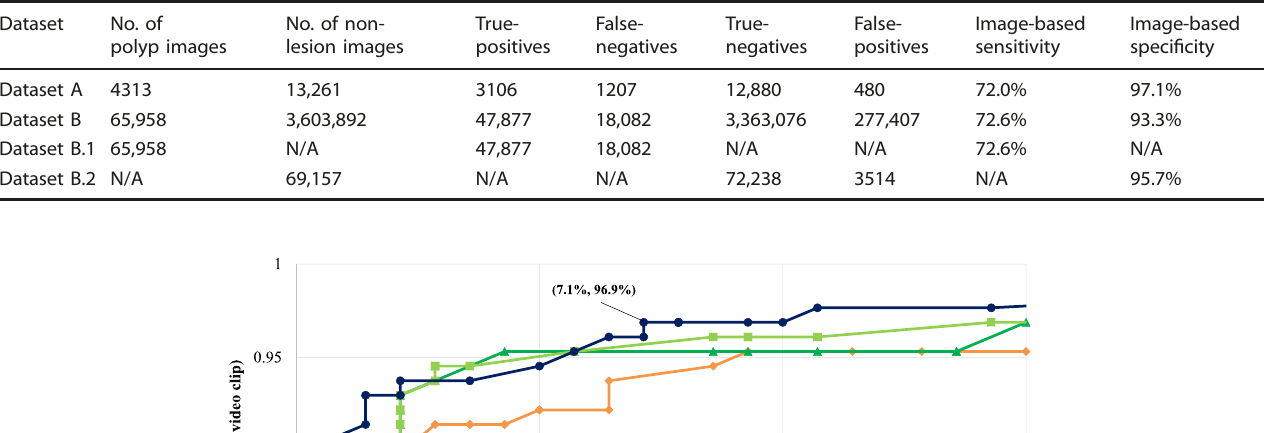
Table 1. Image-based evaluation results of AI-doscopist using training scheme d.